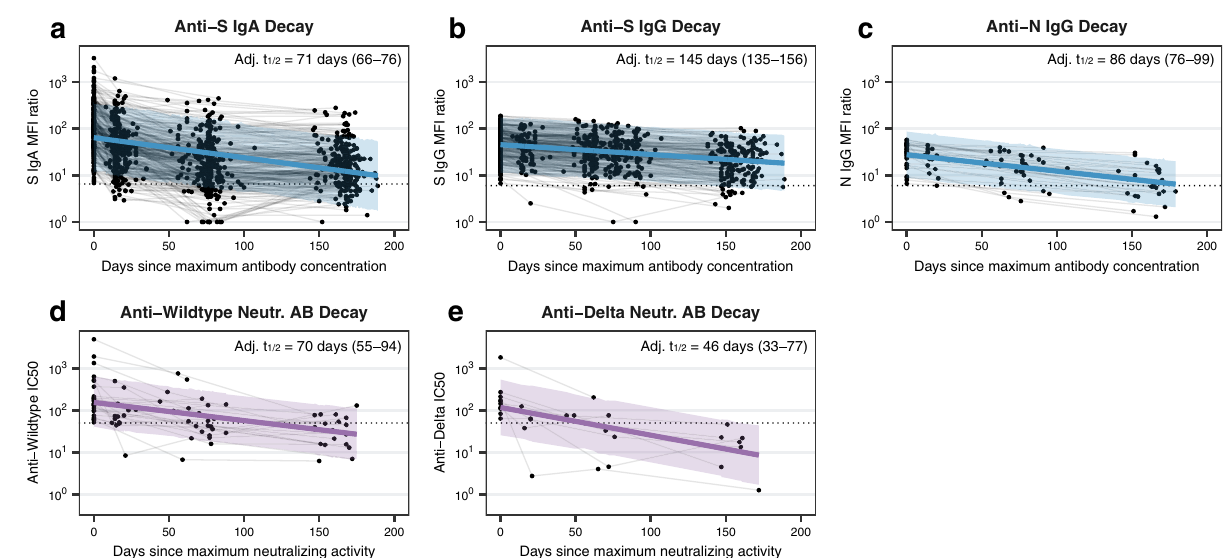
Fig. 3 | Decay estimation for Anti-SARS-CoV-2 S IgA, S IgG, N IgG and neu- tralizing activity. a Anti-S IgA antibody decay estimation within the overall study population based on mixed linear regression model adjusted for time from diag- nosis to maximum mean fl uorescence intensity (MFI) ratio, age group, sex and symptom count,using arandom interceptfor individuals. Lines and error bandsin panels a – e represent regression lines with associated 95% con fi dence intervals estimated using bootstrap. Dotted lines in panels a – e indicate limit of detection cutoffs (6.5 for IgA MFI ratios, 6.0 for IgG MFI ratios, and 50 for half maximal inhibitory concentrations (IC 50 )). Adj. t 1/2 : adjusted half-life with associated 95% con fi denceinterval. b Anti-SIgGantibodydecayestimationwithintheoverallstudy